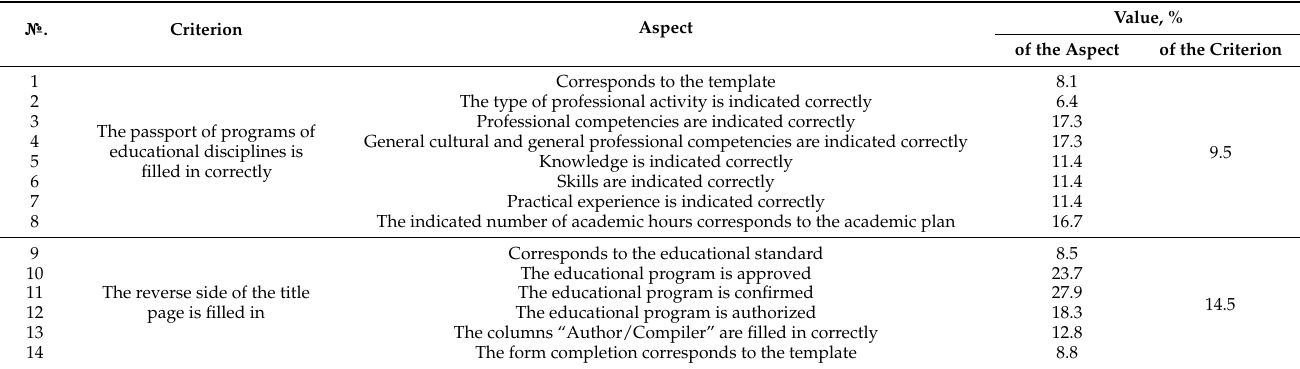
Table 1. A fragment of the results of expert evaluation of the significance of criteria of educational program quality